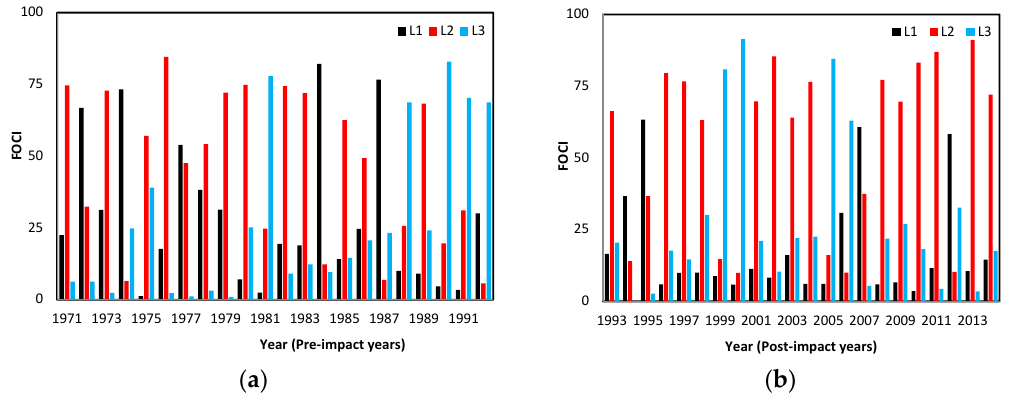
Figure 5. ICOHY of three comparative intervals in pre- and post-impact years (the pre-impact series consists of daily flow data from 1971 to 1992 and the post-impact series consists of daily flow data from 1993 to 2014). ( a ) Alteration in pre-impact period and ( b ) Alteration in post-impact period.